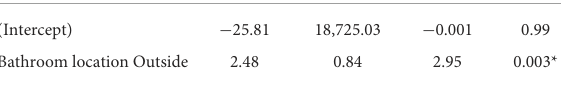
TABLE 5 Parameters of the logistic regression model.